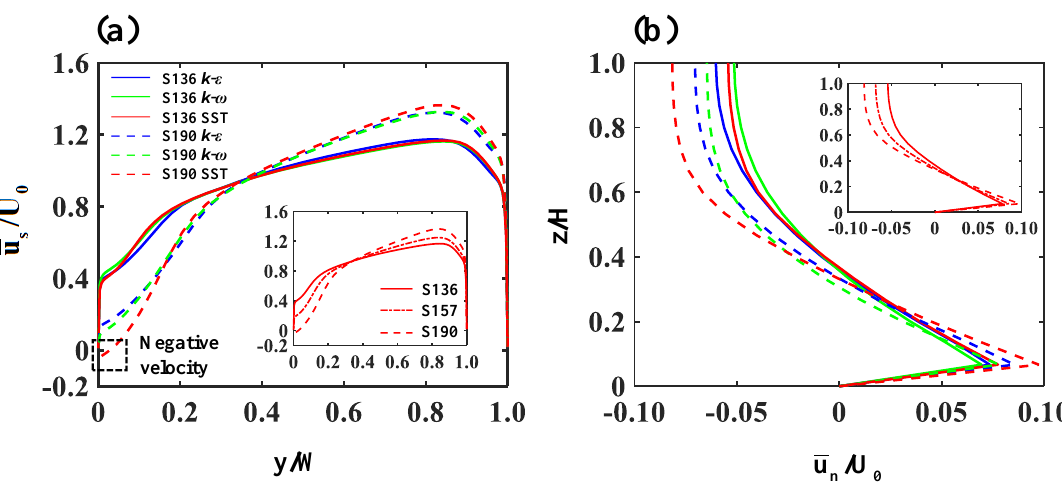
Figure 5. Influence of turbulence models on distributions of ( a ) depth-averaged streamwise velocity and ( b ) width-averaged spanwise velocity at the bend apex for S136 and S190. The insets indicate streamwise and spanwise velocity distributions of the SST k − ω model, as a function of sinuosity.